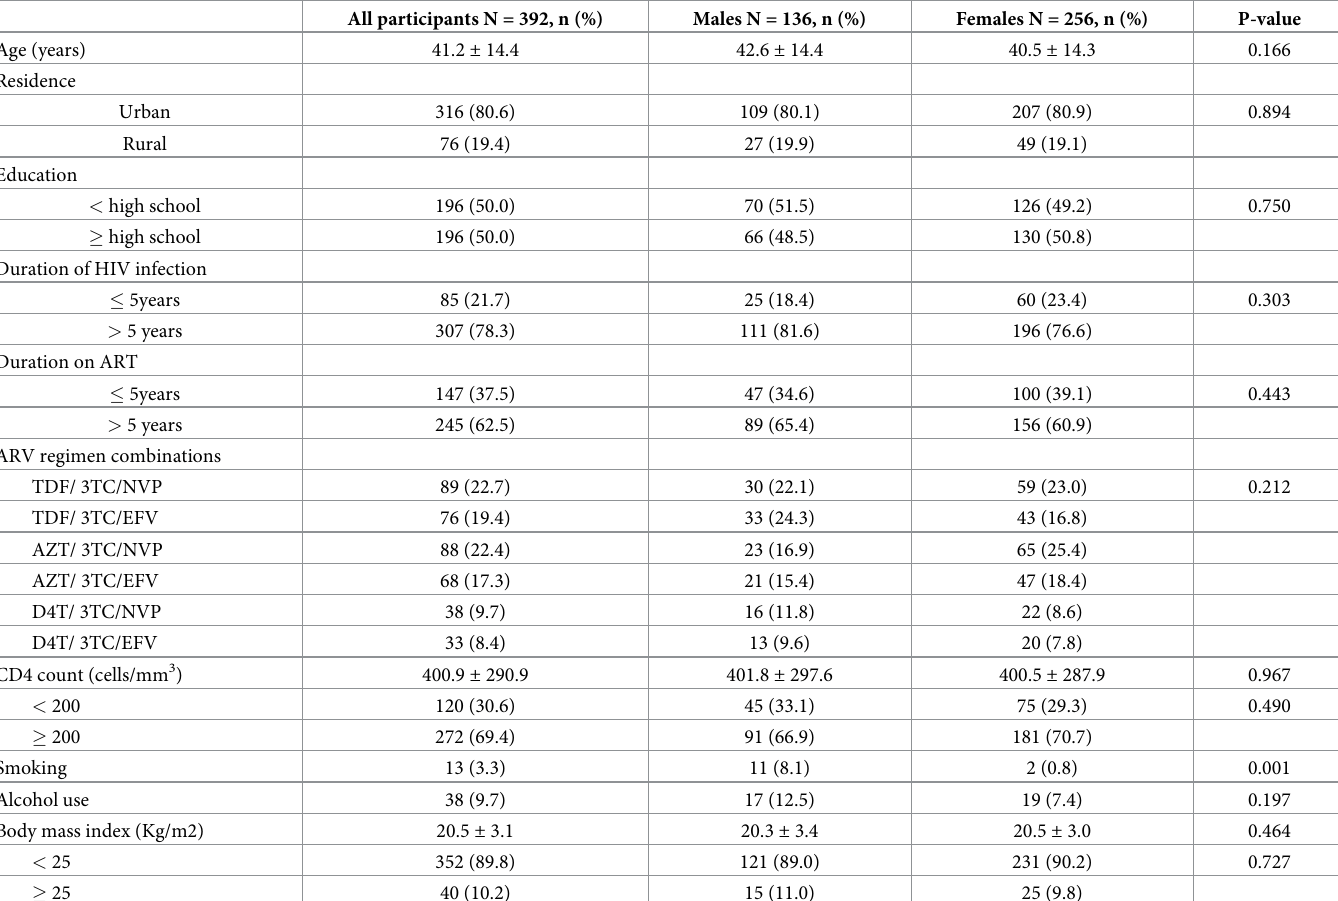
Table 1. Characteristics of study participants in North Shewa, Ethiopia. All participants N = 392, n (%) Males N = 136, n (%) Females N = 256, n (%)